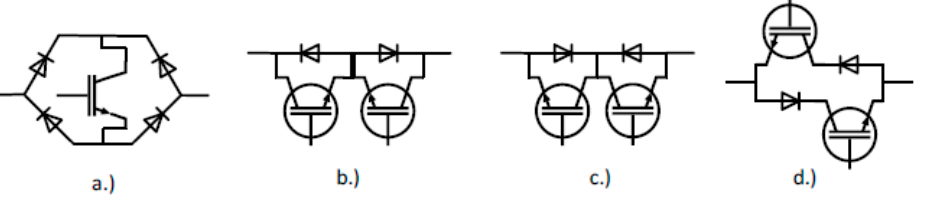
Figure 1. Possible types of the bidirectional switches: ( a ) diode bridge switch; ( b ) common-emitter (CE) switch; ( c ) common-collector (CC) switch; and ( d ) reverse blocking IGBT (RB-IGBT) switch.